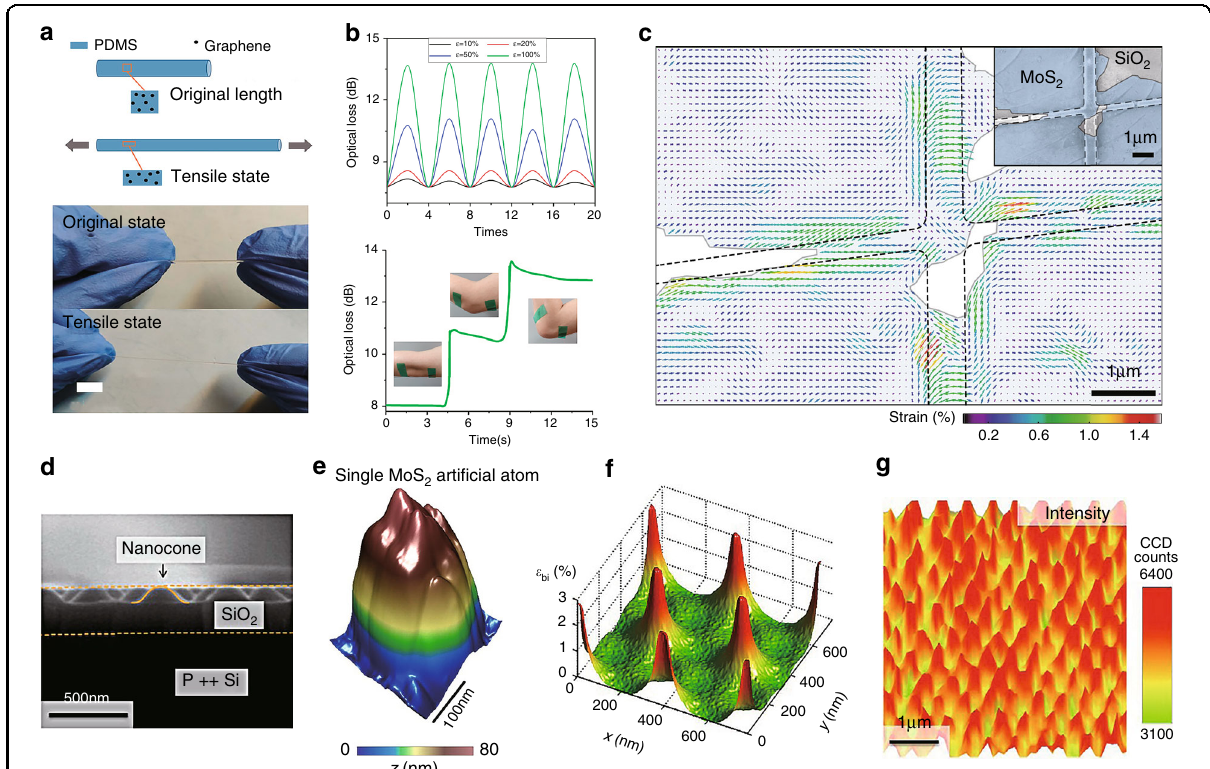
Fig. 10 Strain sensors, SHG-based strain mapping, and broad-spectrum solar energy funnel. a Schematic of a PDMS fi ber incorporating graphene nanocomposites (top panel) and photographs of the hybrid fi ber in the original state and tensile state (bottom panel) 133 . b Strain- dependent optical loss of the fi ber in a (top panel) and that measured with the movement of the human body (bottom panel) 133 . c Strain mapping in MoS 2 by SHG spectroscopy. The inset shows an SEM micrograph of the sample 81 . (Scale bars in both images are 1 μ m.) d Cross-sectional SEM micrograph of silica nanocones on a SiO 2 /Si substrate (Scale bar is 500 nm) 134 . e STM topography of a single MoS 2 “ arti fi cial atom ” consisting of monolayer MoS 2 supported by a single silica nanocone (Scale bar is 100 nm) 134 . f Calculated local strain distribution in strain-textured MoS 2 on the nanocone substrate, and g its PL peak intensity map 134 . The scale bar in g is 1 μ m. Adapted a and b from ref. 133 . Published by MDPI AG. Reprinted c with permission from ref. 81 . Copyright (2018) Springer Nature. Adapted d – g with permission from ref. 134 . Copyright (2015) Springer